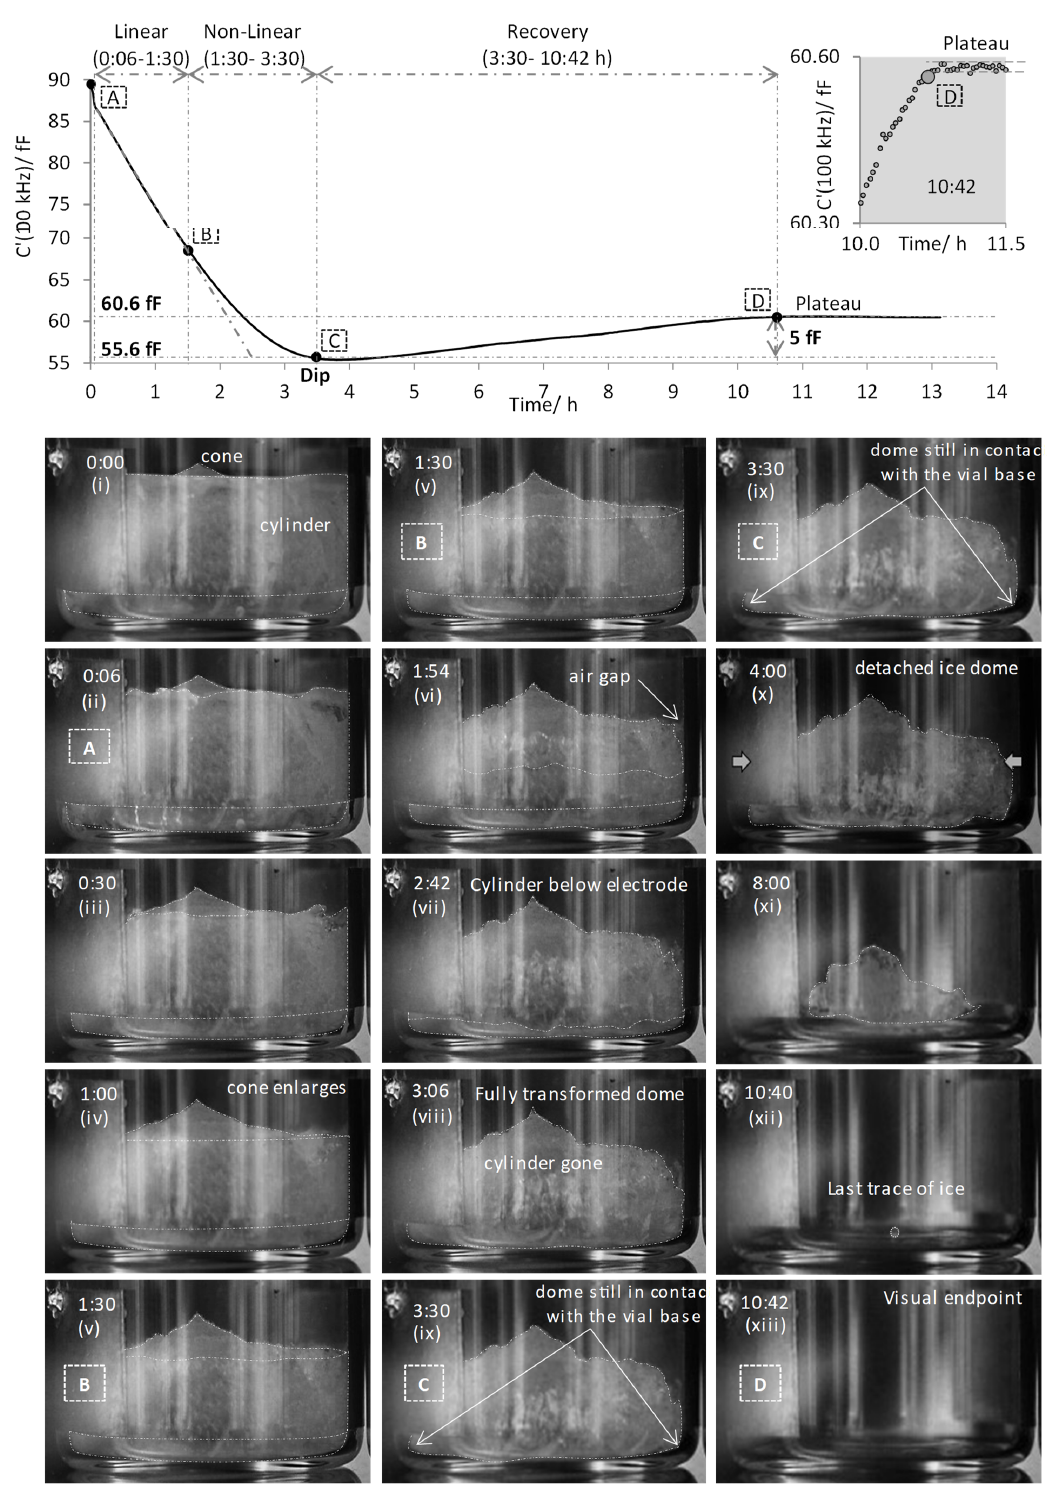
Figure 4. Mapping the facets of the C (cid:48) ( 100 kHz ) time-line for ice contained in the TVIS vial (with electrodes attached externally to the glass wall at a distance of 3 mm from the vial base) on the photographs of the ice sublimation interface during the primary drying phase: The graph at the top shows the time-line of C (cid:48) ( 100 kHz ) with the phases marked A to B, B to C and C to D corresponding to the linear phase, the non-linear phase and the recovery phase, respectively. Shown below are the photographs ( i – xiii ) of the sublimation front at various time-points. The plateau at point D corresponds to the visual endpoint of ice sublimation